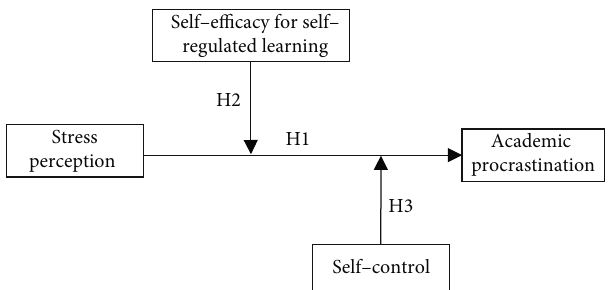
Figure 1: Conceptual map of the relationship between stress perception and academic procrastination and the